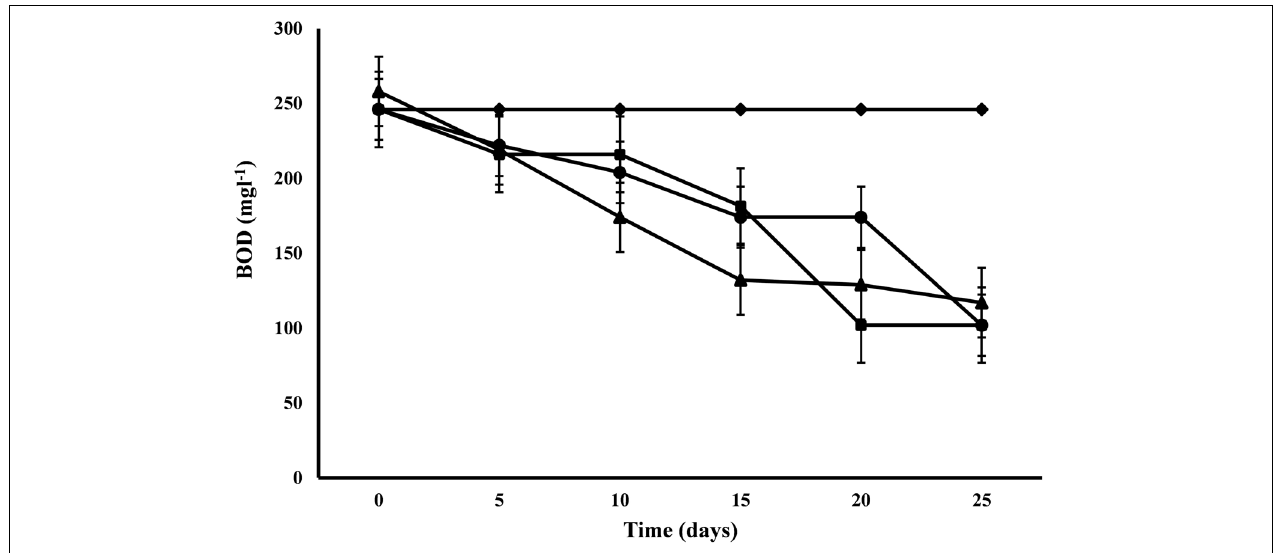
FIGURE 2 | BOD reduction at alternate of 5 days in 3:1 ratio of DWW treated with A. ambigua, C. pyrenoidosa and S. abundans ( (cid:7) -control; (cid:4) - C. pyrenoidosa ; (cid:78) - S. abundans ; - A. ambigua ) (Values represent the mean ± SD of three replicates). (cid:32)